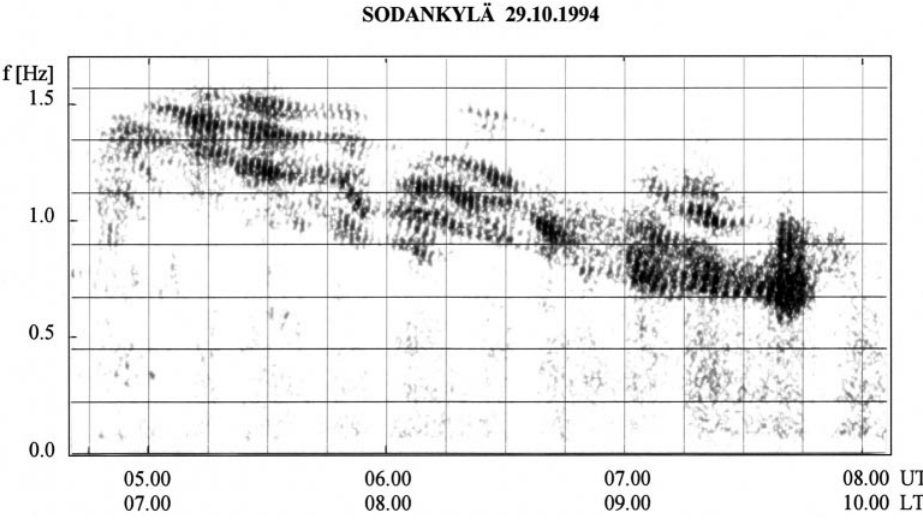
Fig. 1. The sonagram of Pc1 pulsations observed at Sodankyla¨ on October 29, 1994, showing a decreasing